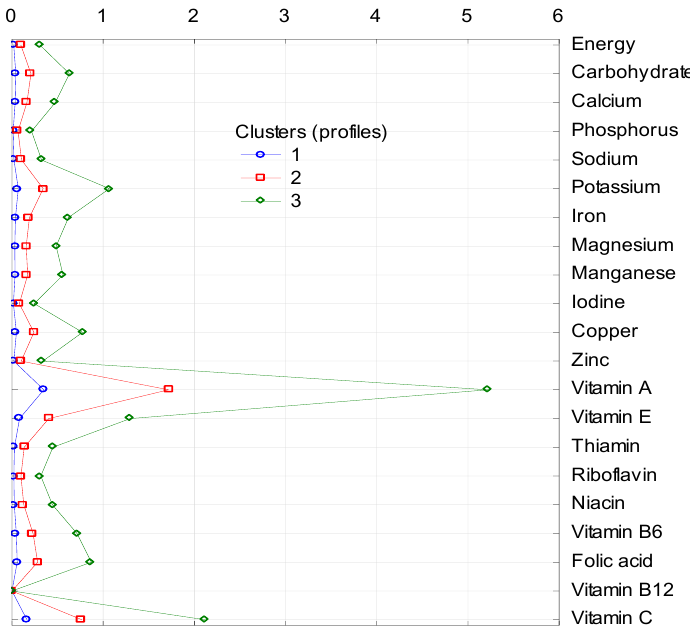
Figure 1. Cluster analysis: supply of energy and analyzed nutrients (in %) from the subgroup of fruit juices to diets in individual clusters. 1, 2, 3 — number of clusters; characteristics of clusters are presented in Table 3.